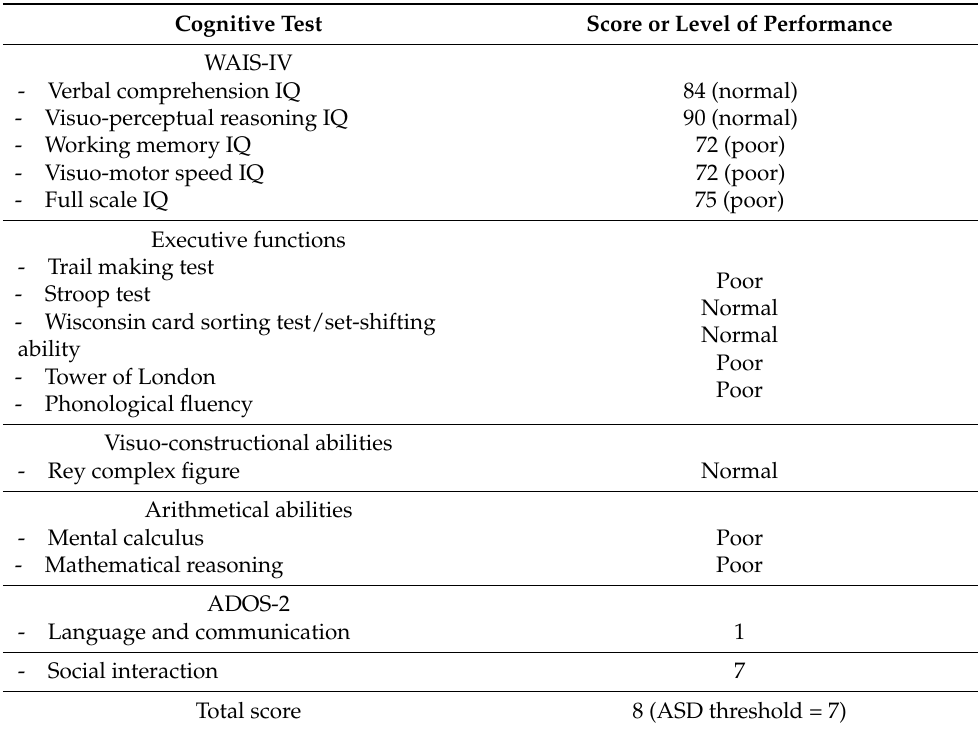
Table 1. Neuropsychological test